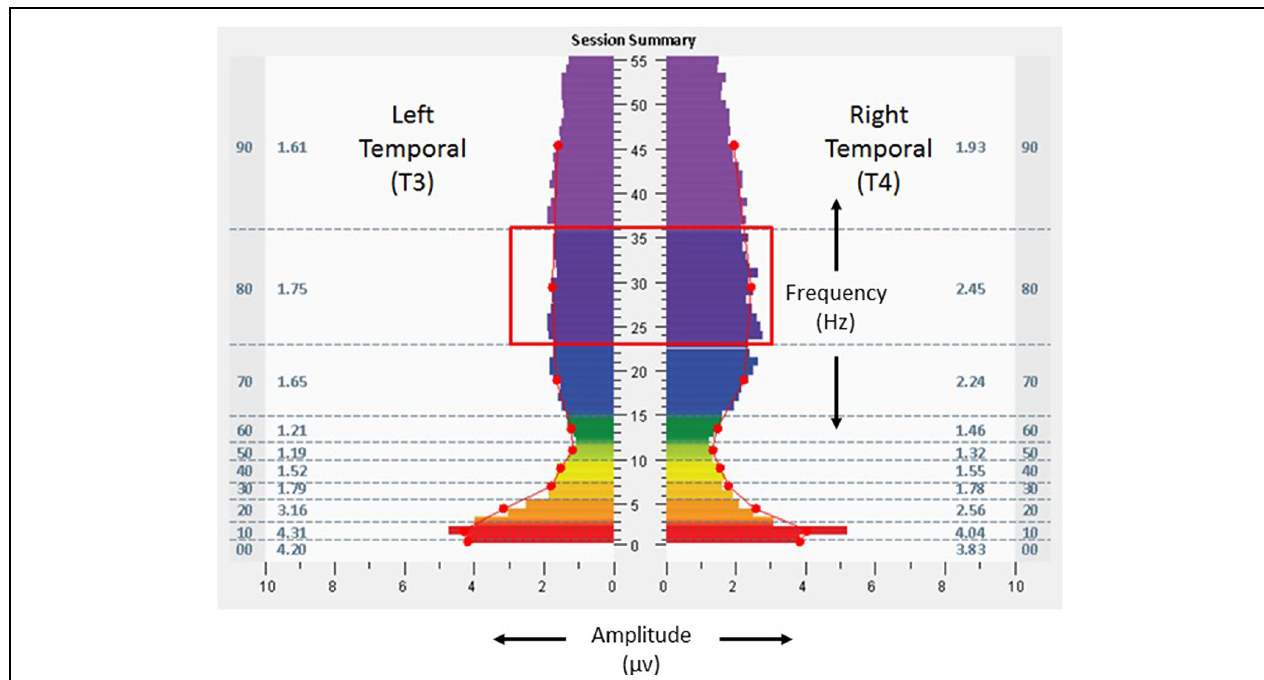
FIGURE 3 | Fast Fourier Transform spectral display of 1 min recording of brain electrical activity at the left and right temporal lobe (T3 left, T4 right), with eyes closed, during the baseline assessment, from the 18-years-old learner described in text. Red box denotes the 23–36 Hz frequency range mentioned in the text. See Figure 2 legend for detailed explanation of data elements.